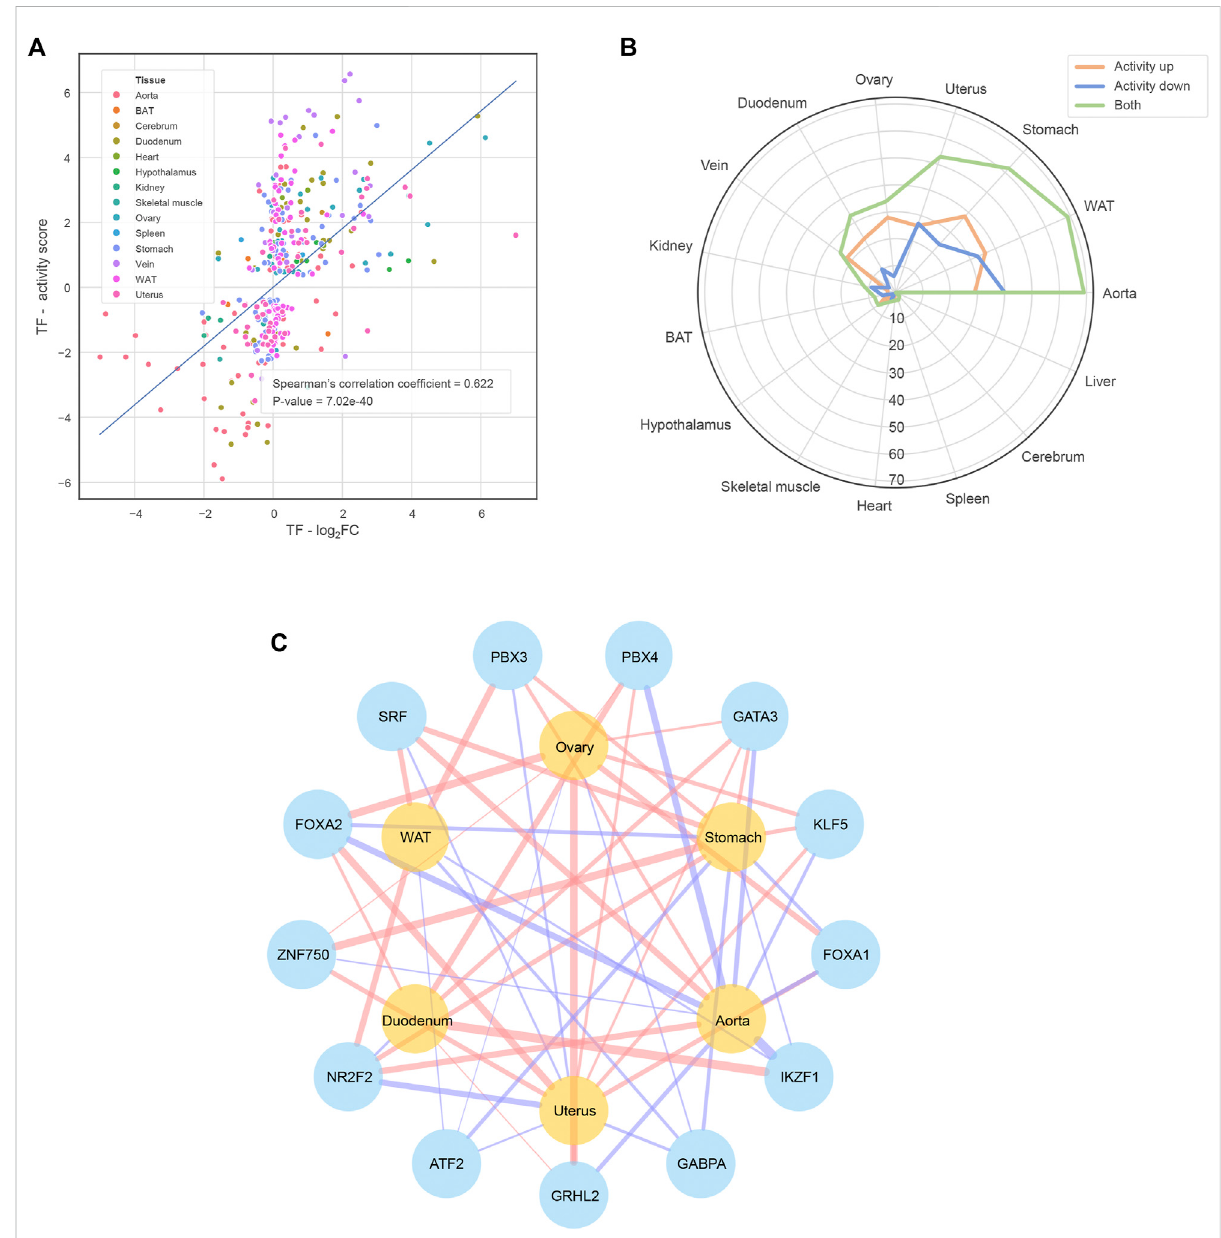
FIGURE 3 Functional TFs identi fi ed by the CIE tool (A) The strong positive correlation between the functional TFs ’ expression abundance fold change and downstream transcriptionalregulation activity. Thetranscriptional regulation activityis quanti fi edbyshrunk CIEq-value,namelytheactivityscore of the y -axis (B) The number of functional TFs of each tissue (C) The TFs shared by at least four ECTTs. The red/blue TF-tissue links mean that the TFs exhibit signi fi cantly increased/decreased activity in corresponding tissues when comparing estrus versus diestrus and the link width shows the activity score de fi ned in the subplot